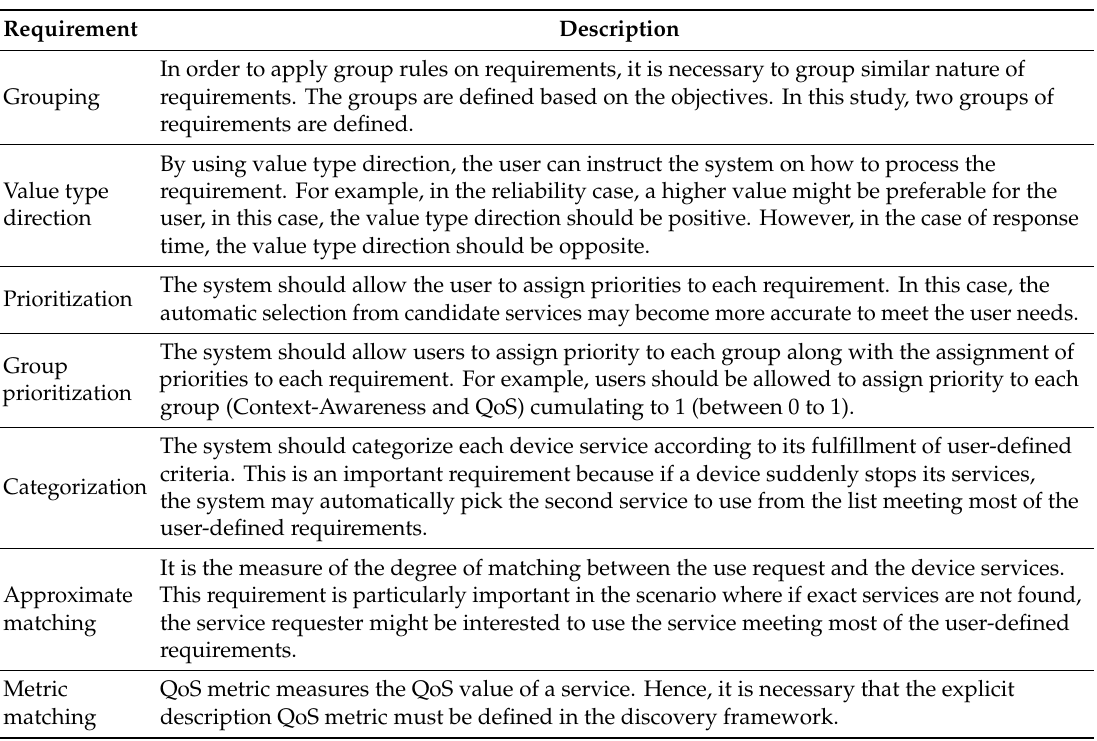
Table 1. Smart system’s general criteria